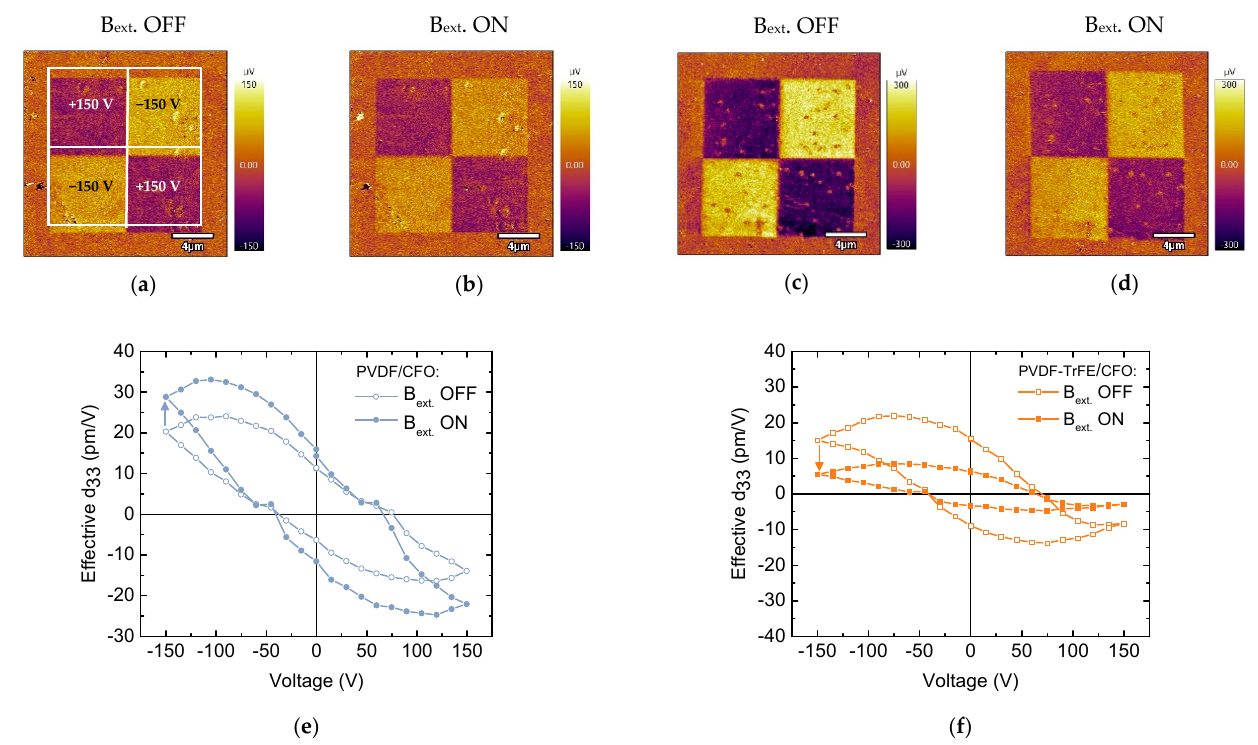
Figure 8. Piezoresponse force microscopy (PFM) images ( a – d ) and remnant local piezoelectric hysteresis loops ( e , f ) at applied (B ext. ON) and switched off (B ext. OFF) the magnetic field (B ext. = 1.4 kOe) for ( a , b , e ) PVDF/CFO and ( c , d , f ) PVDF-TrFE/CFO samples.